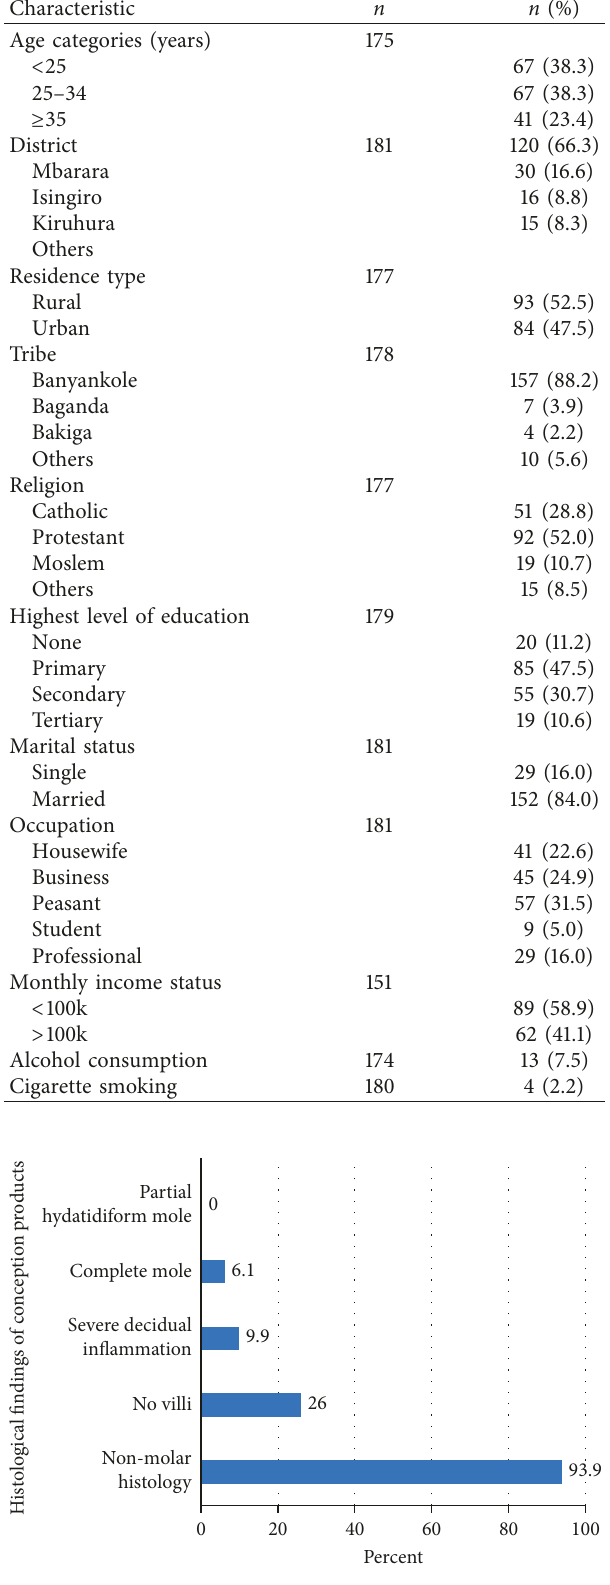
Table 1: Sociodemographic and behavioral characteristics of patients.